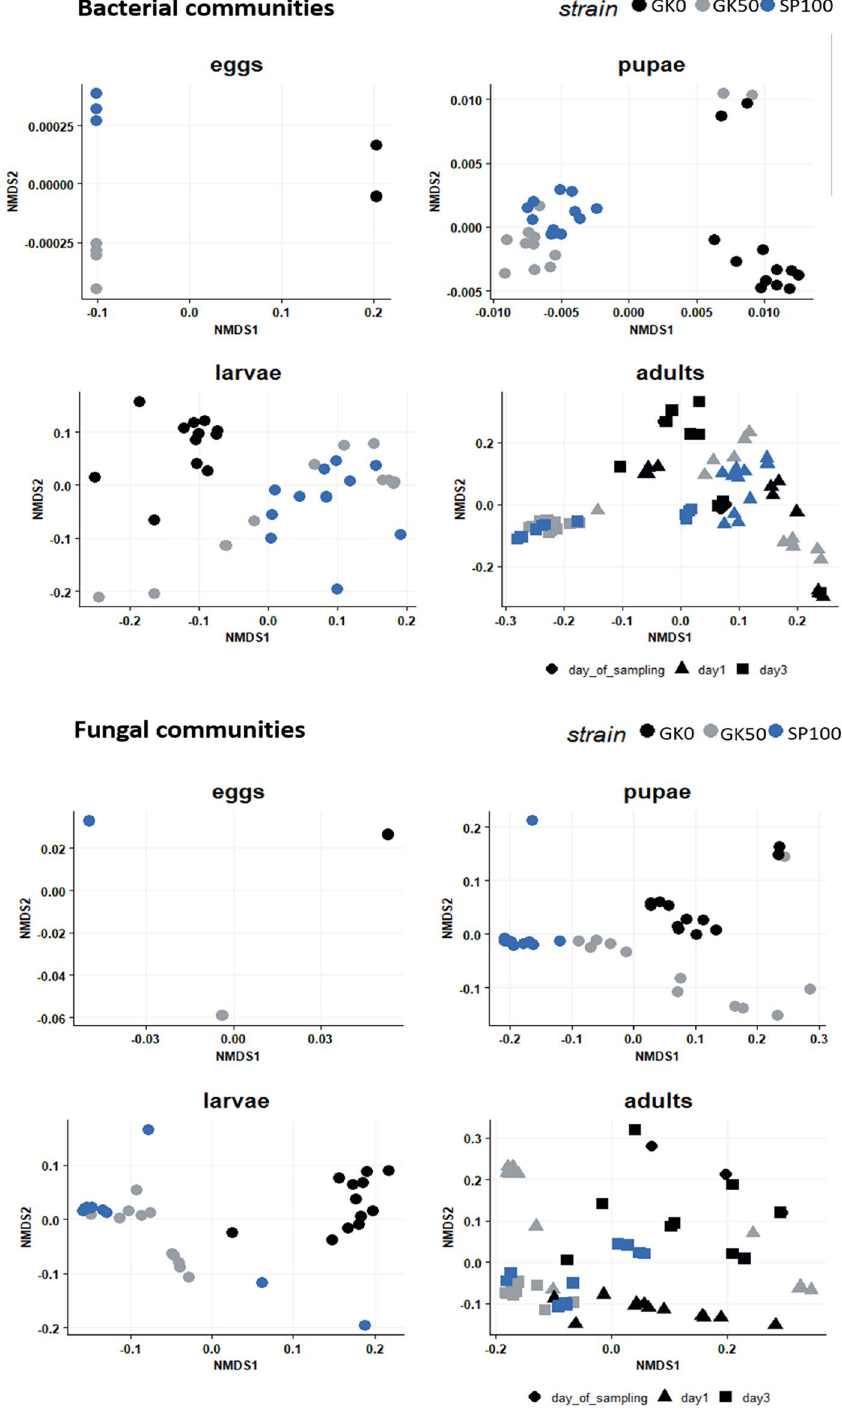
Figure 3. ( a ) Bacterial communities for each developmental stage of three housefly strains based on weighted Unifrac. NMDS stresses: 9.05e-05 (eggs), 0.09 (larvae), 0.08 (adults),0.06 (pupae) ( b ) Fungal communities for each developmental stage based on weighted Unifrac. NMDS stresses: 9.91e-05 (eggs), 0.07 (larvae), 0.06 (pupae), 0.15